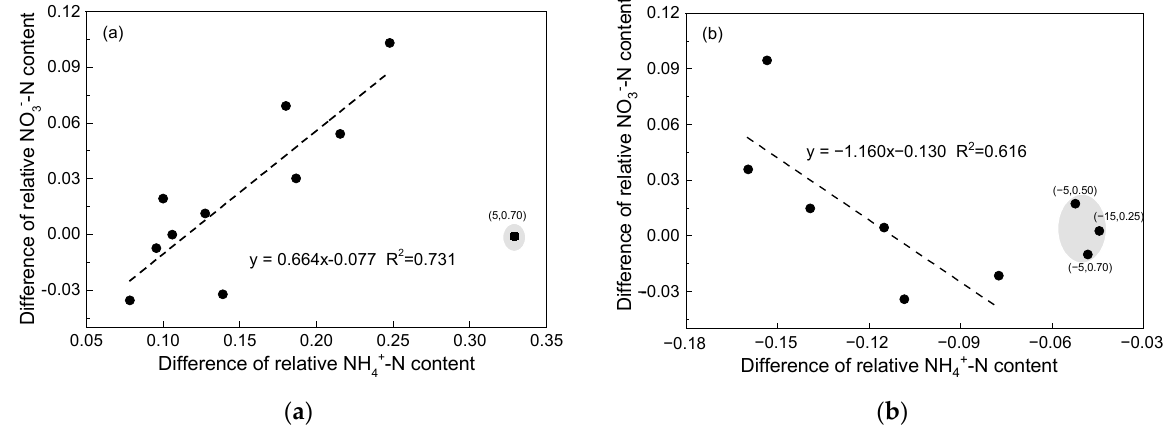
Figure 8. Relationship between the relative NH 4+ -N and NO 3 − -N content differences caused by increased soil water content (SWC) (40–80% water holding capacity (WHC)) in treatments with low soil salt content (SSC) and high freezing temperature ( a ) and in treatments with high SSC and low freezing temperature ( b ).